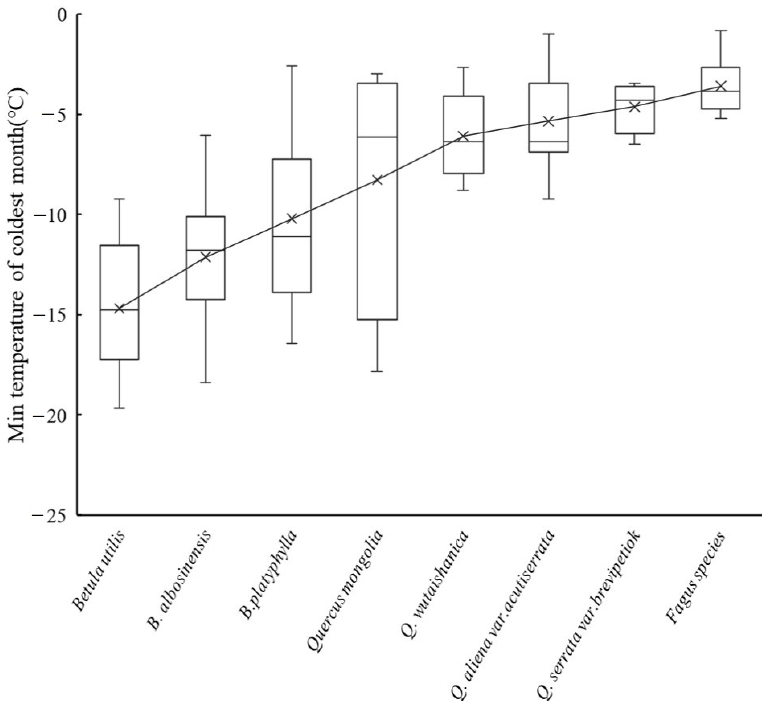
Figure 7. Characteristics of the minimum temperature of the coldest month of species dominating the upper limit of the montane deciduous broad-leaved forest. The line in the boxplot, and the upper and lower whiskers of the boxplot represent the median, interquartile range (from 1st to 3rd quartile). “ × ” in the boxplot represents the average of the minimum temperature of coldest month at the upper limit of MDB with same dominant species. “ Fagus spp . ” in the graph represents the dominant species of overall beech forest on the subtropical mountains, belonging to the genus Fagus . In the study, we did not show the characteristics of the minimum temperature of the coldest month for each species belonging to the genus Fagus , because the site number of each species belonging to the genus Fagus was less than 5, which was insufficient to generate boxplots.